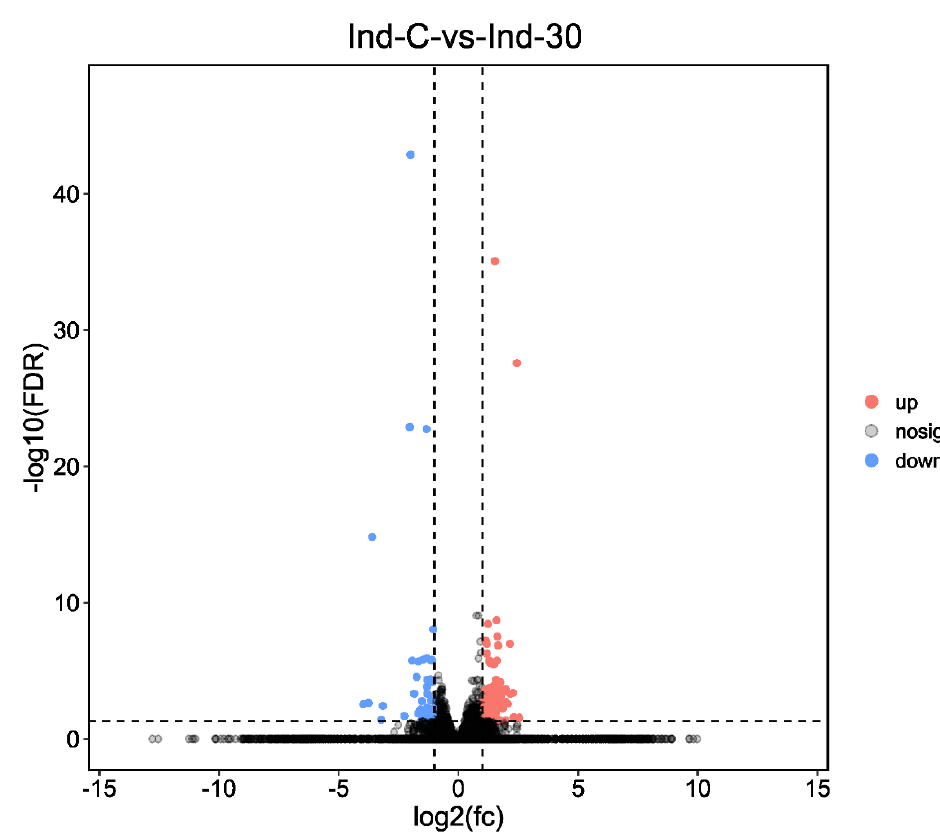
Figure 2. Differentially expressed unigenes after 24 h of exposure in indoxacarb-treated (Ind-30) and control (Ind-C) group. The fold change in gene expression is represented on the X-axis. The dotted x-axis indicates the relevance of gene expression statistically. p -value less than 0.05 is shown on the y-axis by − log10 (FDR). Scattered dots represent different genes. The grey dots represented no significant regulation, orange dots showed significantly upregulated genes, and blue dots showed significantly downregulated genes.